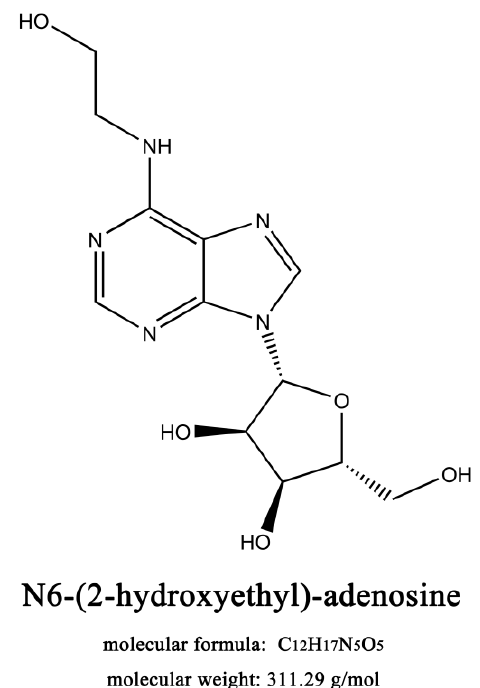
Figure 1. Chemical structure of HEA. The molecular formula of HEA is C 12 H 17 N 5 O 5 , and the molecular weight is 311.29 g /